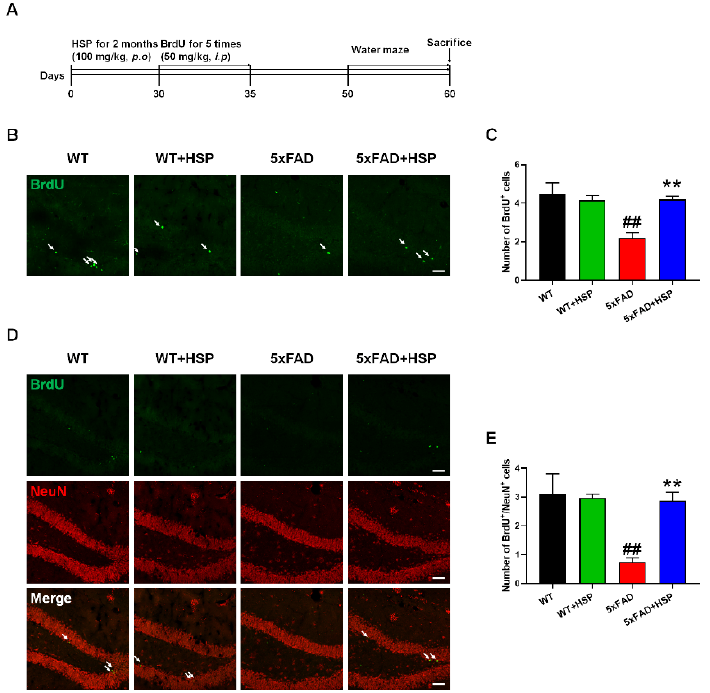
Figure 3. The effects of hesperidin on neurogenesis in the hippocampus of 5xFAD mice. Mice were administered with vehicle or HSP (100 mg/kg) once daily for two months. ( A ) In vivo